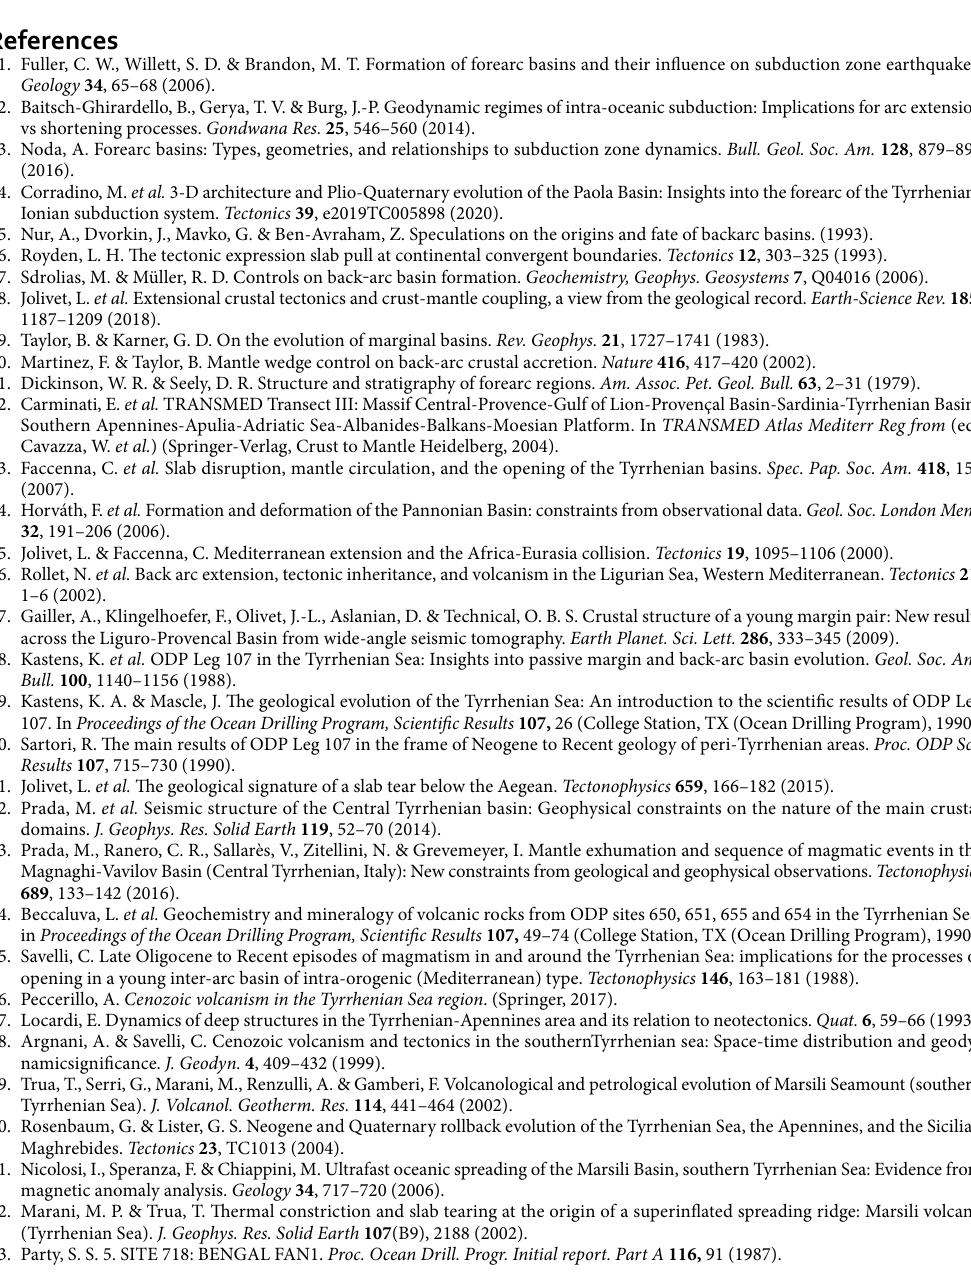
of solid rocks at given P (MPa) and T (K) computed from: